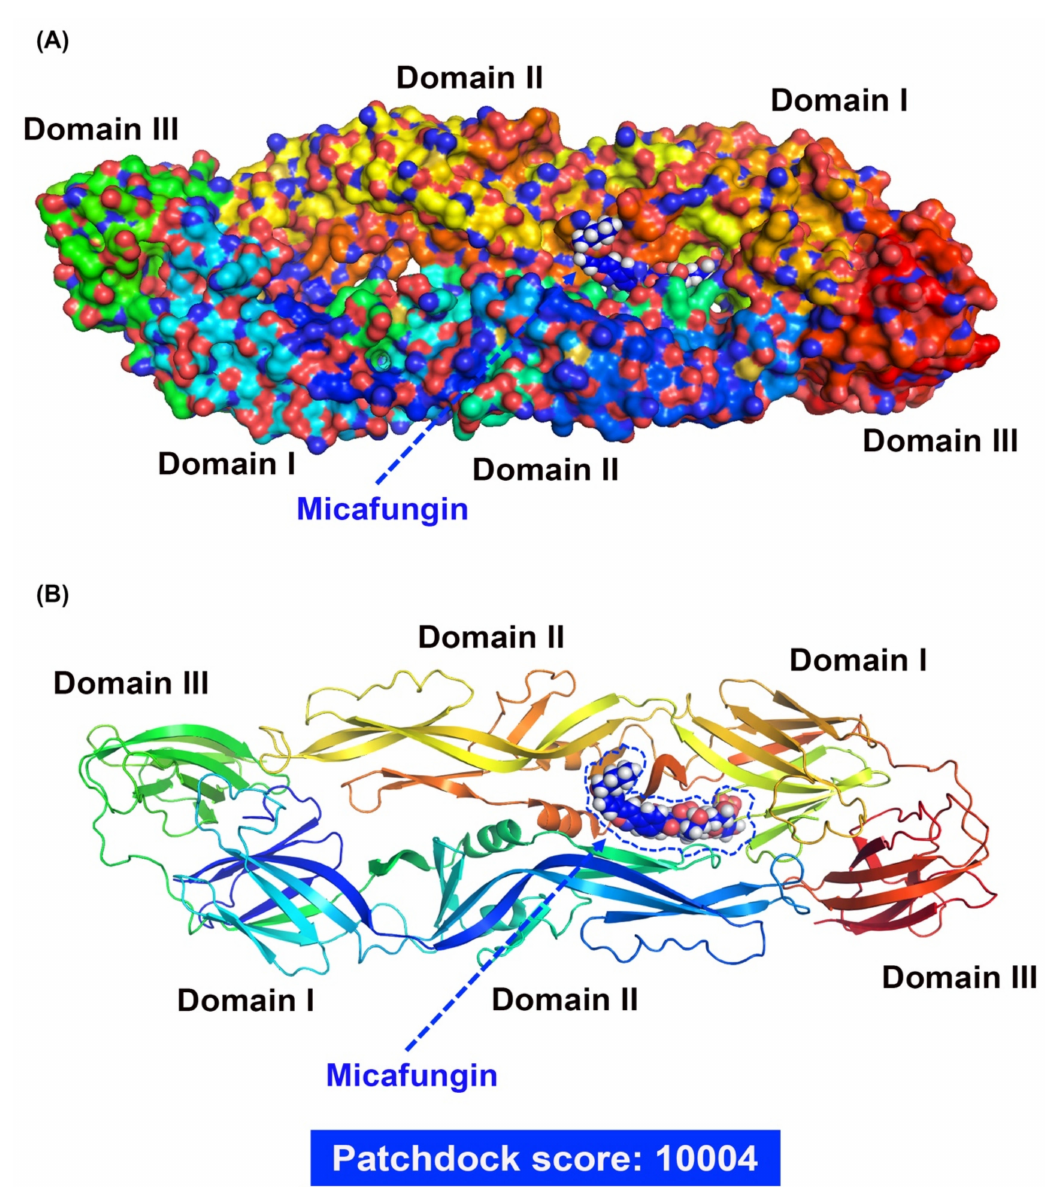
Figure 4. ( A ) Spheres rendered overview of DENV-2 envelope protein docked with micafungin and ( B ) interaction of DENV-2 envelope proteins with micafungin via molecular docking